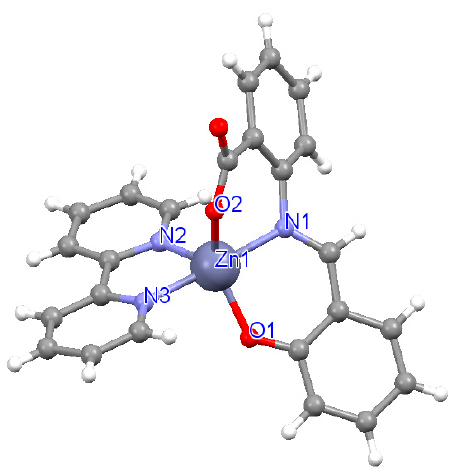
Figure 1. Structure of complex 1. Selected bond lengths (A) and bond angles (deg) are: Zn1-O1